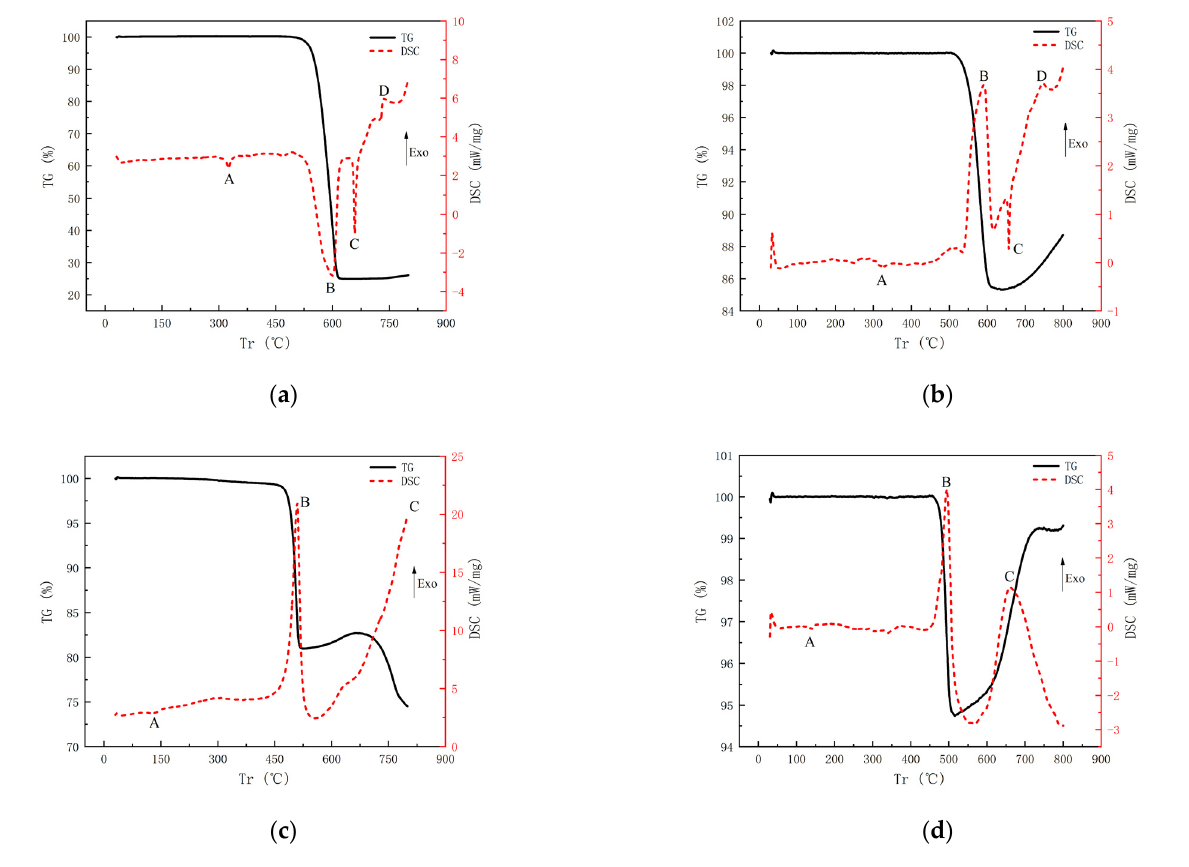
Figure 9. DSC/TG results of RMs: ( a ) 26.5% Al/73.5% PTFE ( b ) 5.29% Al/80% W/14.71% PTFE ( c ) 62% Hf/38% THV ( d ) 88% Hf/12% THV. The TG/DSC curves of Hf/THV are shown in Figure 9c,d. The endothermic peak A is the melting endothermic peak of THV. Significantly different from Al/PTFE, two exothermic peaks (B and C) are observed in the DSC curves, both of which are